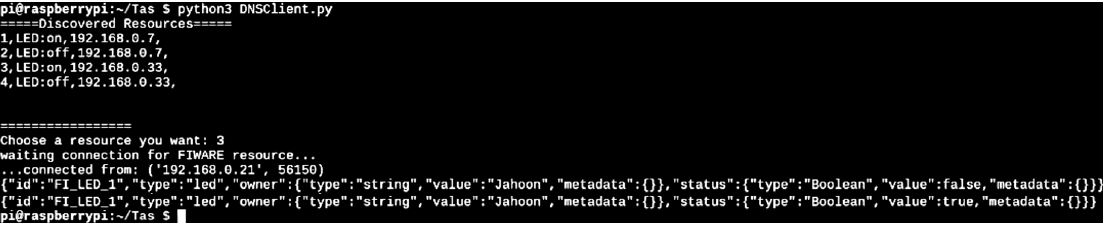
Figure 19. Status information of the FIWARE.